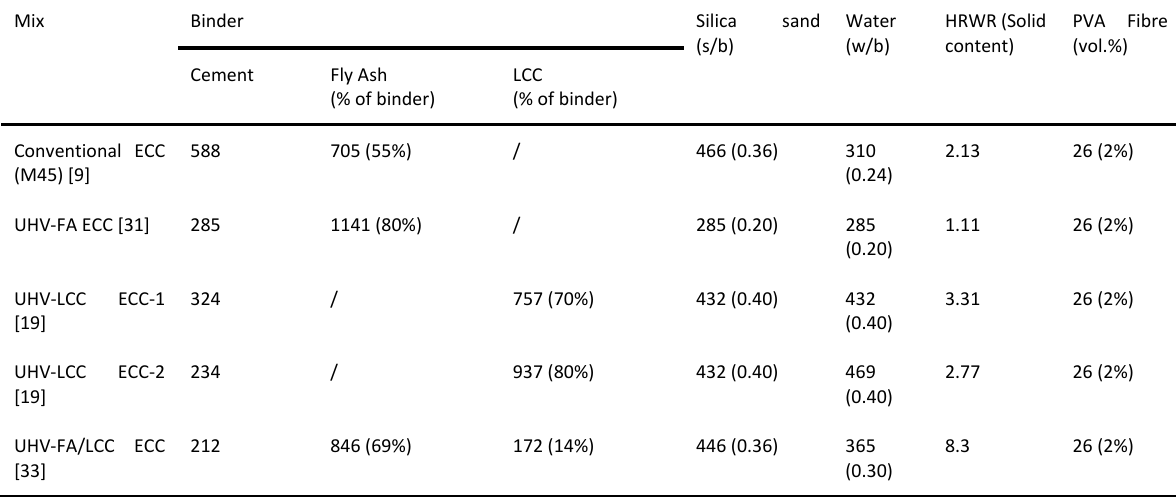
Table 1. Mix proportions (in kg/m 3 ) of ECC with ultrahigh ‐ volume FA/LCC